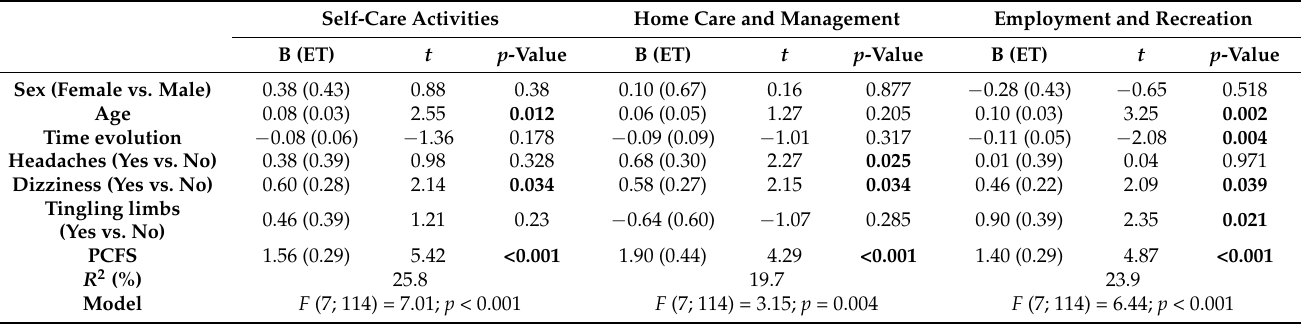
Table 4. Effect of demographic and clinical variables on the self-care activities, home care and management, and employment and recreation dimensions of the ADLQ